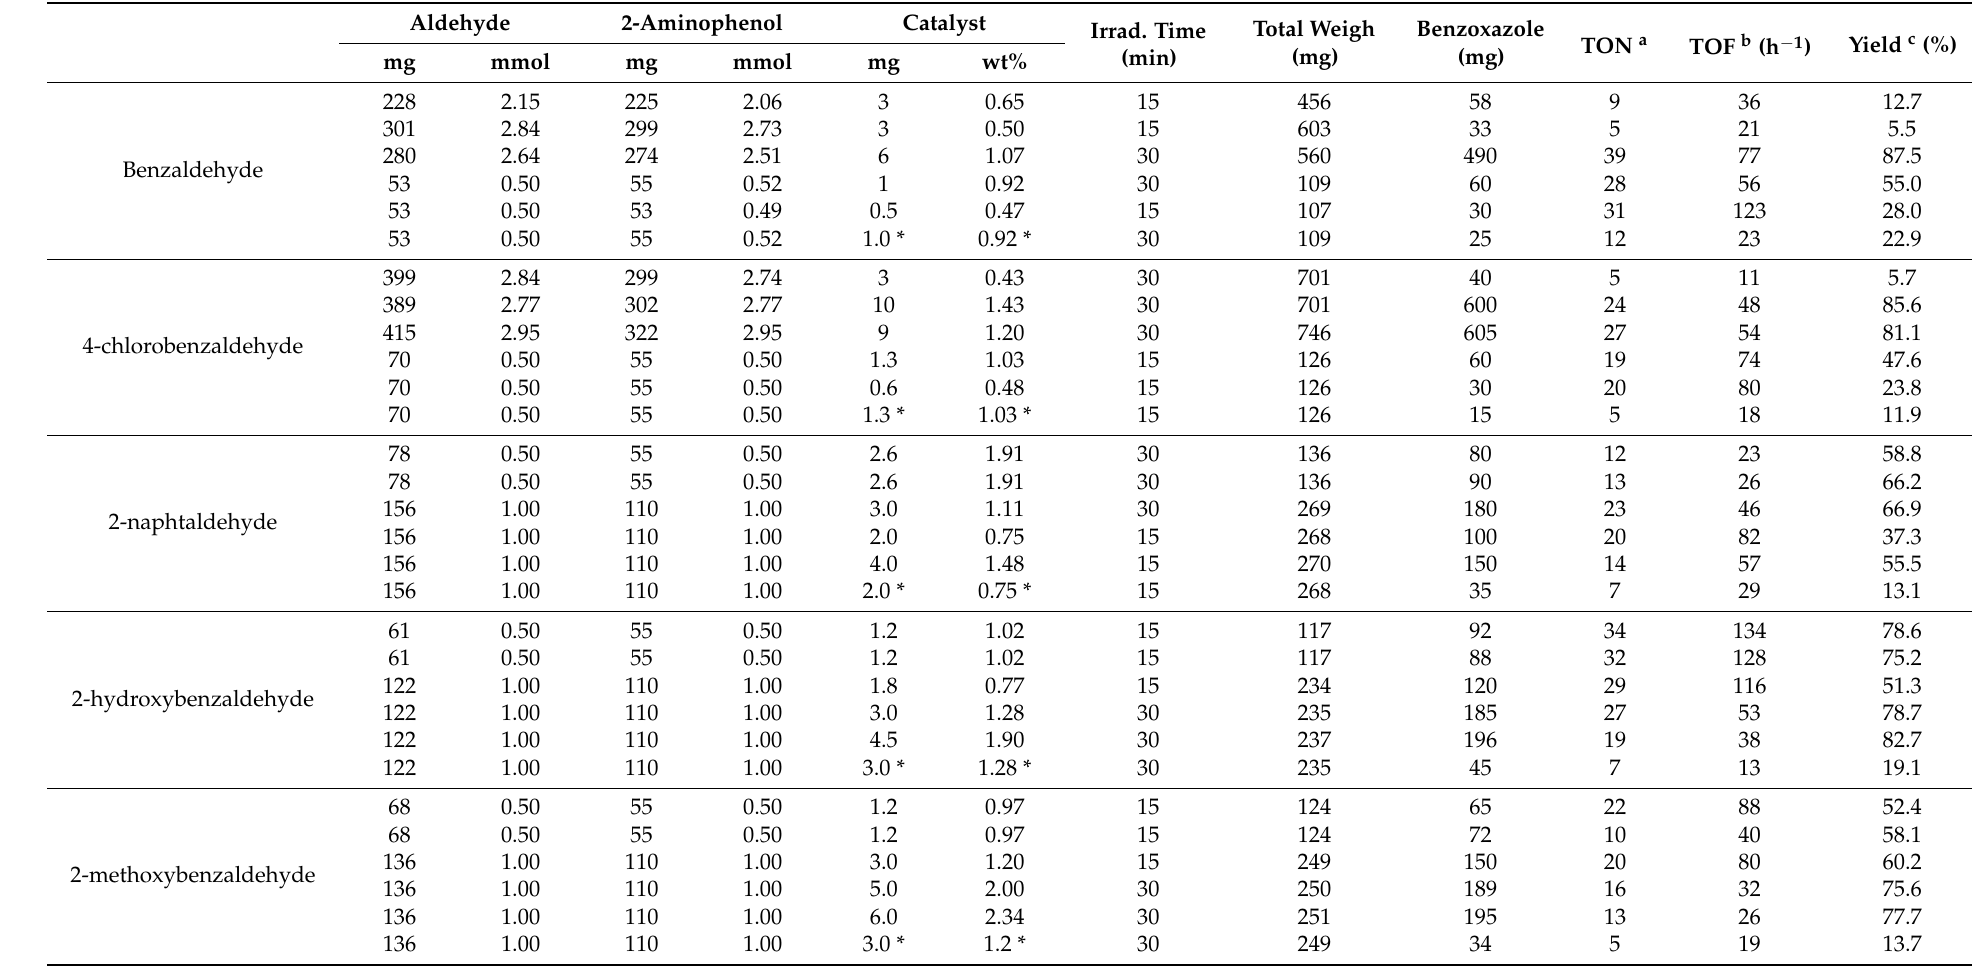
Table 3. Photocatalytic conditions for the synthesis of benzoxazoles using F,O,S-codoped g-C 3 N 4 vs. pristine g-C 3 N 4 (labeled with an